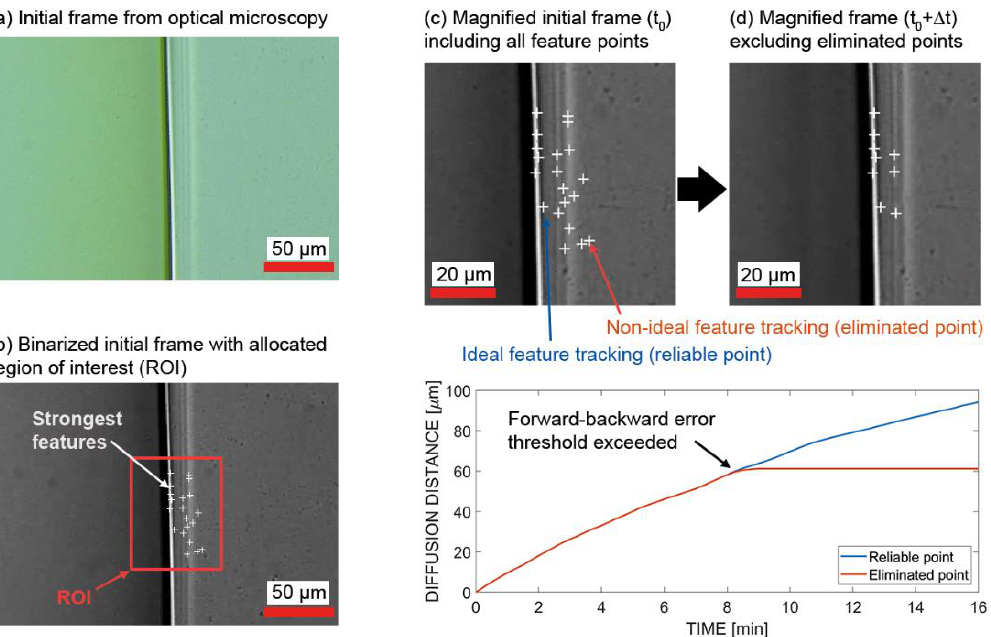
Figure 2. Identification of robust features and extraction of reliable tracking points: ( a ) initial frame at the beginning of diffusion from optical microscopy without post-processing; ( b ) binarized initial frame with allocated region of interest (ROI) in MATLAB; ( c ) magnified initial frame at diffusion step t 0 including strongest feature points detected by Shi–Tomasi corner detector algorithm; and ( d ) magnified frame at diffusion stept 0 + ∆ t, excluding eliminated points due to exceedance of the forward – backward error threshold.